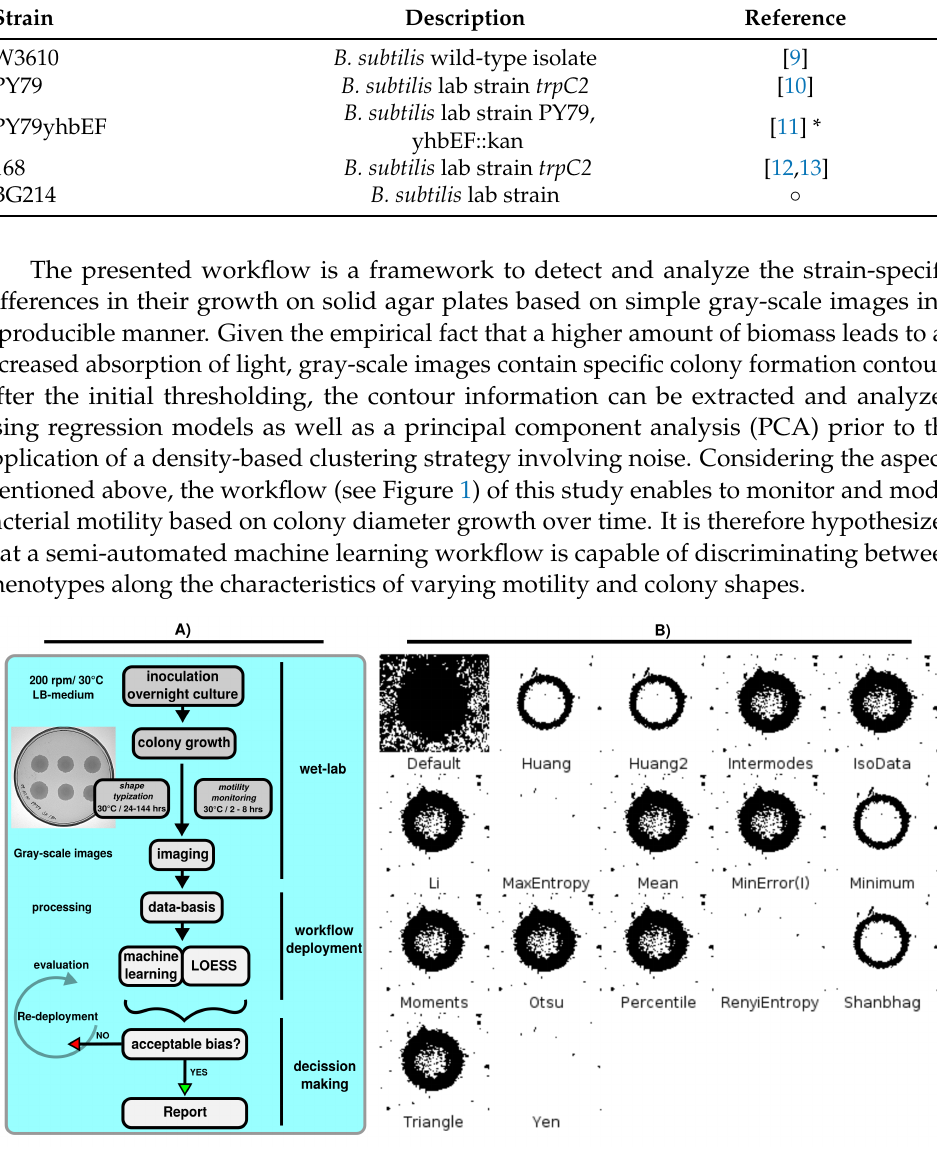
Figure 1. ( A ) Schematic illustration of the presented workflow showing key stages of the pipeline. Improvements can be established using densely conducted documentation in combination with useful information that resulted after re-deployment during bias-minimization steps. These can start at every stage of the pipeline. However, maintaining the database is of key importance due to the fact that downstream processing and analysis is directly influenced upon changes that are made to the data. Data management is indispensable for reproducible research using machine learning.